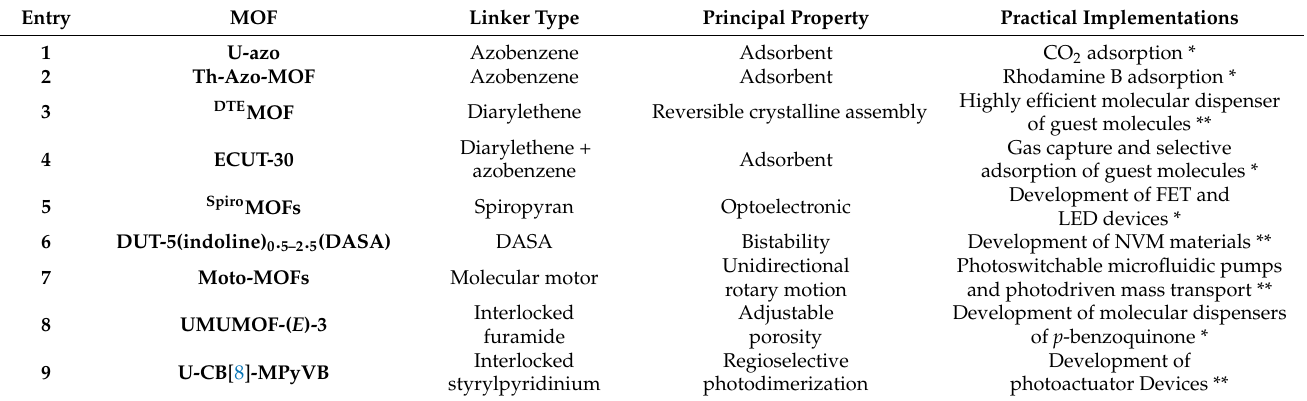
Table 1. General considerations of the selected photoresponsive MOFs